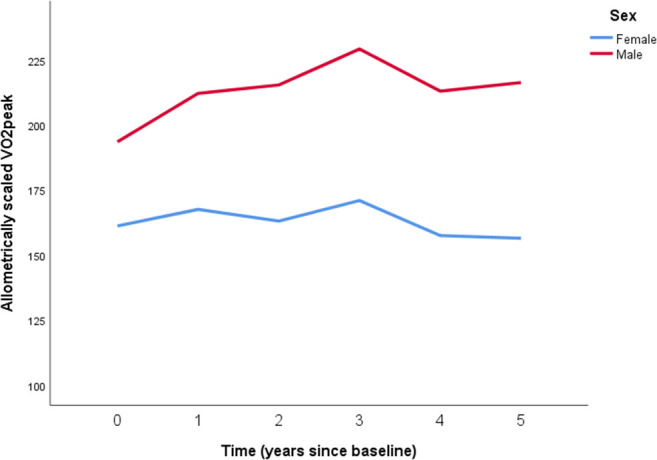
Longitudinal development of peak oxygen uptake (VO2peak) with body mass allomterically scaled to the power of 0.67 for 61 boys (red line) and 55 girls (blue line) from the age of 14–19. Overall mean and pooled SD for boys: 212.4 ± 29.1 mlO2·kg−0.67·min−1. Overall mean and pooled SD for girls: 162.8 ± 24.3 mlO2·kg−0.67·min−1. Time is years from baseline: Time 0 = 8th grade, Time 1 = 9th grade, Time 2 = 10th grade, Time 3 = 1st year high school, Time 4 = 2nd year high school, Time 5 = 3rd year high school.